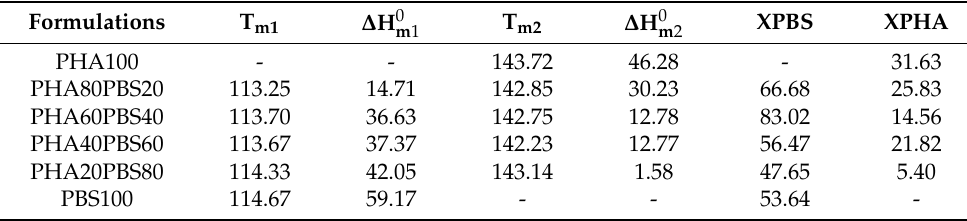
Figure 2. DSC curves of PHA/PBS blends. Table 4. Transition temperature and crystallinity of PHA/PBS